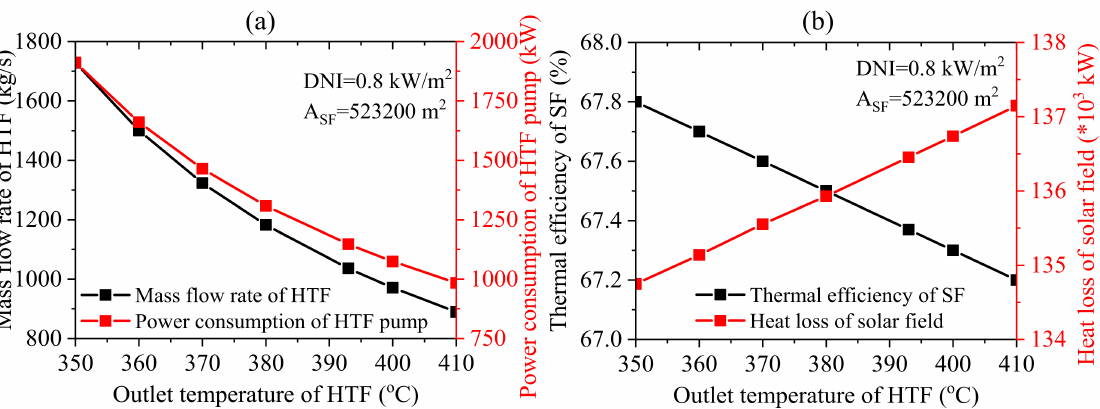
Figure 12. Effect of outlet temperature of the HTF on the operating parameters of the solar field: ( a ) mass flow rate of HTF and power consumption of HTF pump; ( b ) thermal efficiency and heat loss of the solar